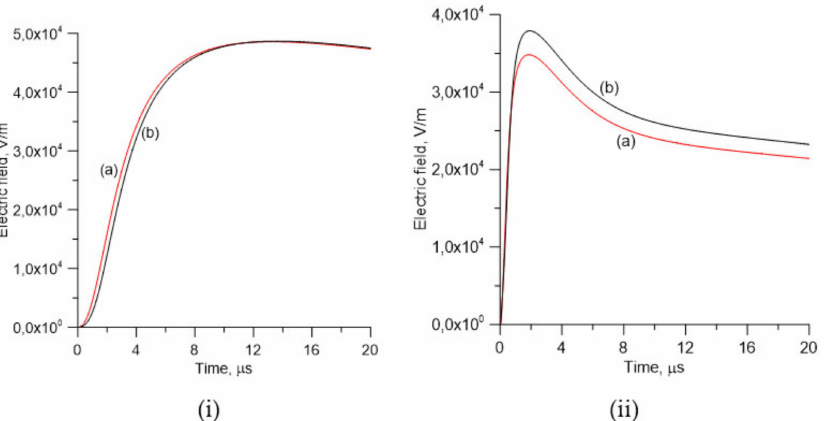
Figure 3. ( i ) The vertical electric field generated by a first return stroke at the point d = 30 m, ζ = 10 m. The speed of propagation of the return stroke is 1.0 × 10 8 m/s. ( ii ) The vertical electric field generated by a subsequent return stroke at the point d = 30 m, ζ = 20 m. The speed of propagation of the return stroke is 1.5 × 10 8 m/s. The curve marked (a) in red represents the exact and (b) in black represents the Rusck